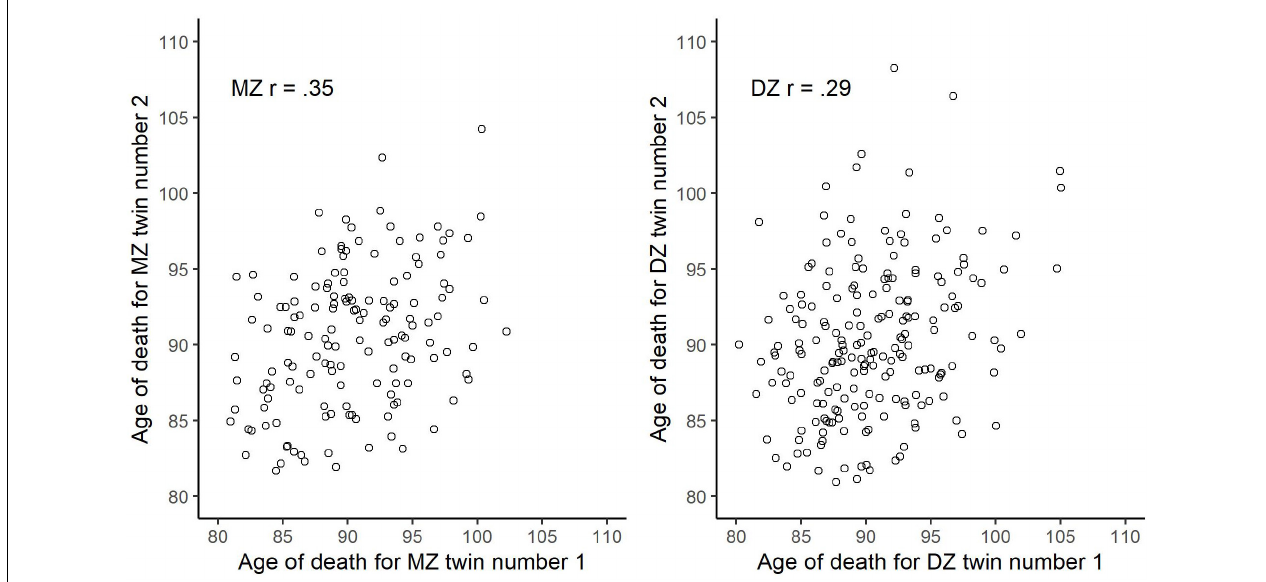
FIGURE 2 | Bivariate scatter plot of age of death across randomly drawn within-twin-pair individuals stratified by zygosity.